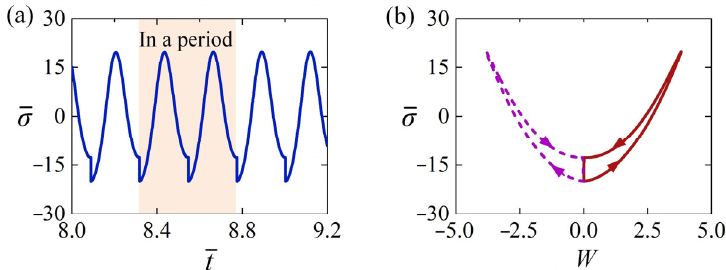
Figure 6. ( a ) The time history of normal stress of the rod shown in Figure 3c,d. ( b ) The dependence of normal stress on lateral displacement in a cycle of Euler buckling. The normal stress of the rod varies periodically during dynamic Euler buckling.